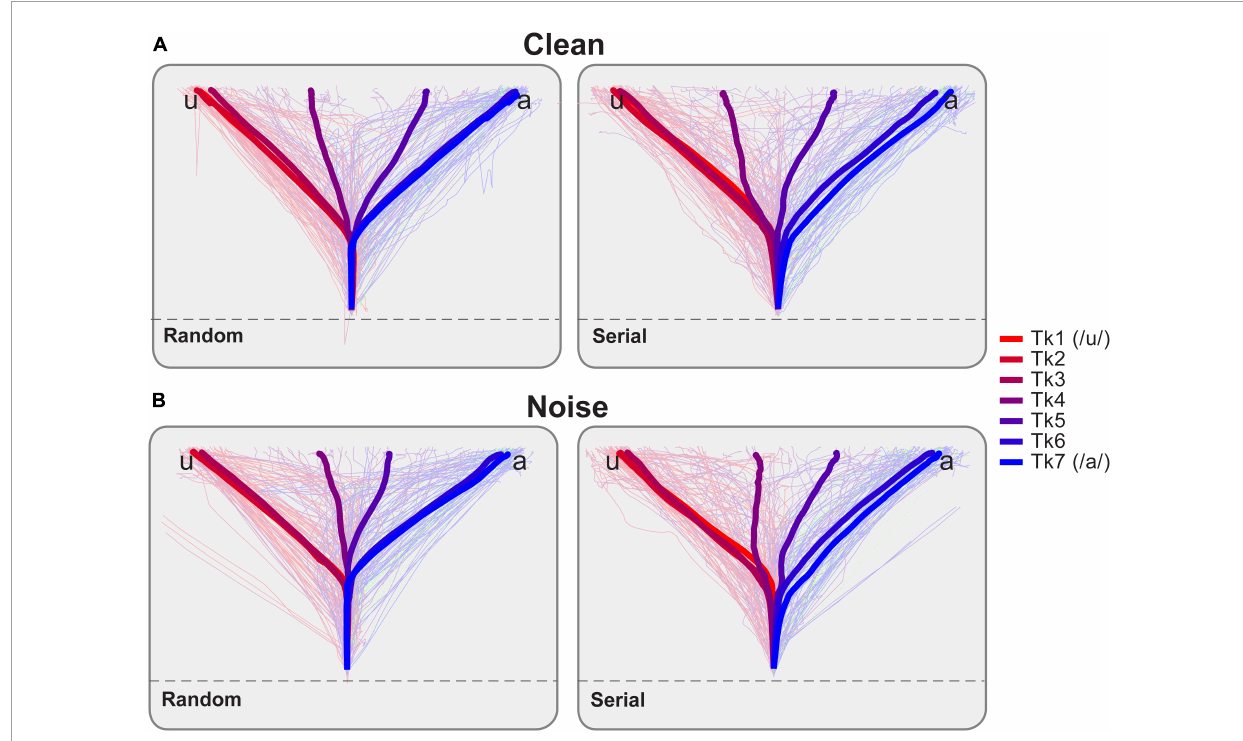
FIGURE3 Mouse trajectories reflect continuous dynamics in vowel identification as a function of noise and stimulus ordering. Light traces = single trials, Bold thick traces = grand average tracks per vowel token. Forward and reverse directions are pooled for the serial order. Once participants moved the mouse across an invisible threshold on the screen (dotted line), a speech token was played. They then identified which vowel they perceived by moving toward either the “u” or “a” character presented on either side at the top of the display. Response tracks for (A) clean and (B) noise-degraded speech. Listeners’ response tracks were more direct toward endpoint tokens (i.e., those heard with a strong category identity; Tk1, Tk7). Midpoint tokens, which are more category ambiguous, elicited tracks which appear more centered on the screen, indicating listeners split their decisions between categories. Note also differences in the bowing of mouse trajectories for serial vs. random presentation